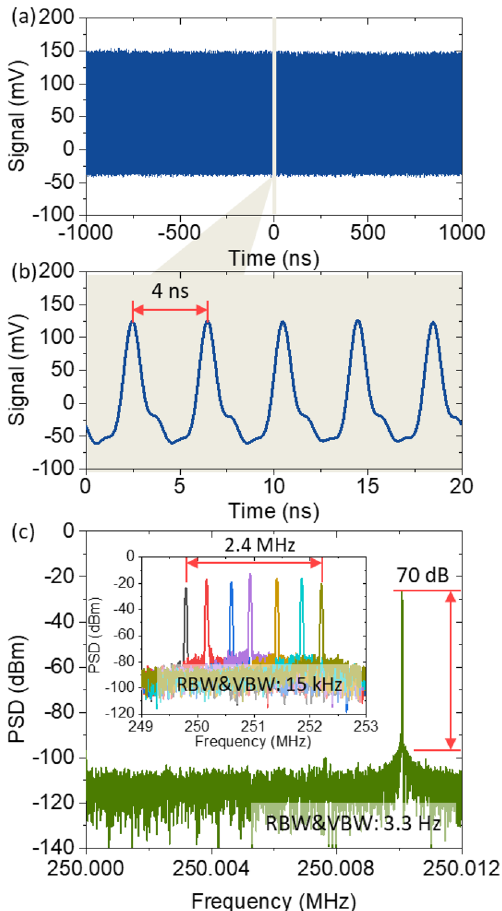
Figure 3. RF domain characteristics of the C-band tunable mode-locked laser: ( a ) output pulse trains over 2000 ns. ( b ) Zoomed-in view of Fig. 2a for 20 ns. ( c ) RF spectrum at the fundamental repetition rate with a resolution bandwidth and video bandwidth of 3.3 Hz. The inset shows the tunability of the repetition rate from 249.8 to 252.2 MHz with a resolution bandwidth and video bandwidth of 15